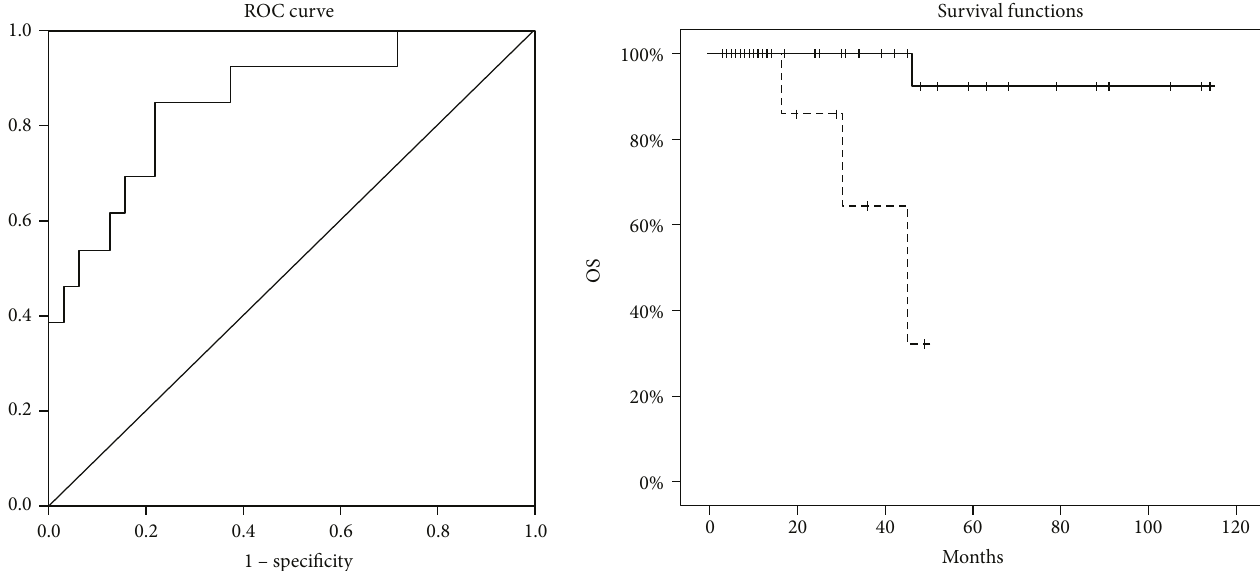
Figure 2: ROC curve for the prediction of early progression of disease (ePD) (left) and Kaplan-Meier OS curve for the two subgroups (continuous line: no ePD, 108 ± 5 months, 95% CI 98-118 line, ePD: 38 ± 4 months, 95% CI 28-48 months, p < 0 001 ).